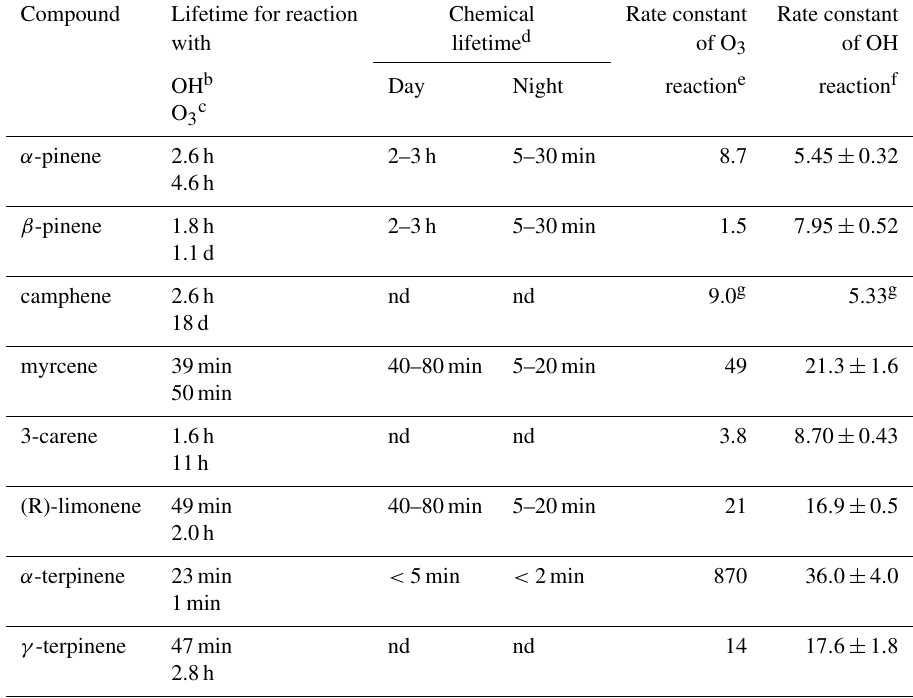
Table 1. Monoterpenes included in the present study, listed together with their atmospheric lifetime. Compound Lifetime for reaction Chemical Rate constant Rate constant with lifetime d of O 3 of OH OH b Day Night reaction e reaction f O 3c α -pinene